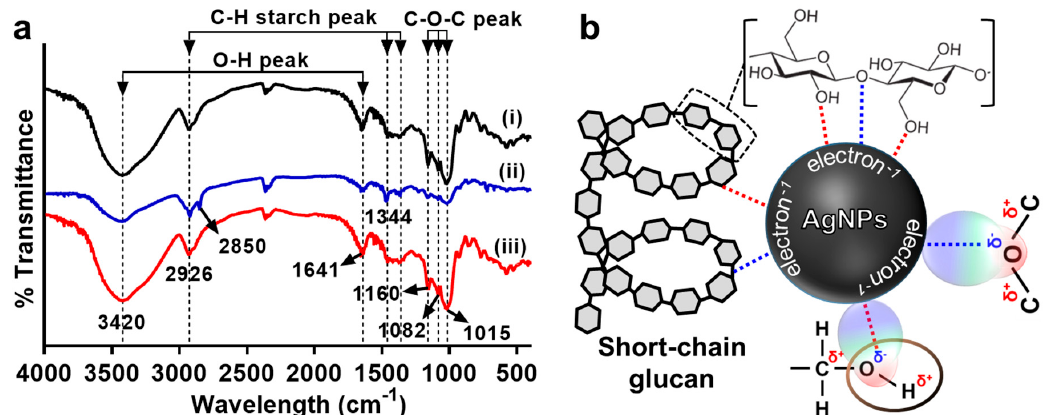
Figure 3. ( a ) Fourier transform infrared (FTIR) spectra of debranched SCG (i), DS-AgNPs (ii), and gelatinized starch (iii). ( b ) A cartoon illustration showing dipole–dipole interactions between AgNPs and short-chain glucans obtained from the debranching of native starch.